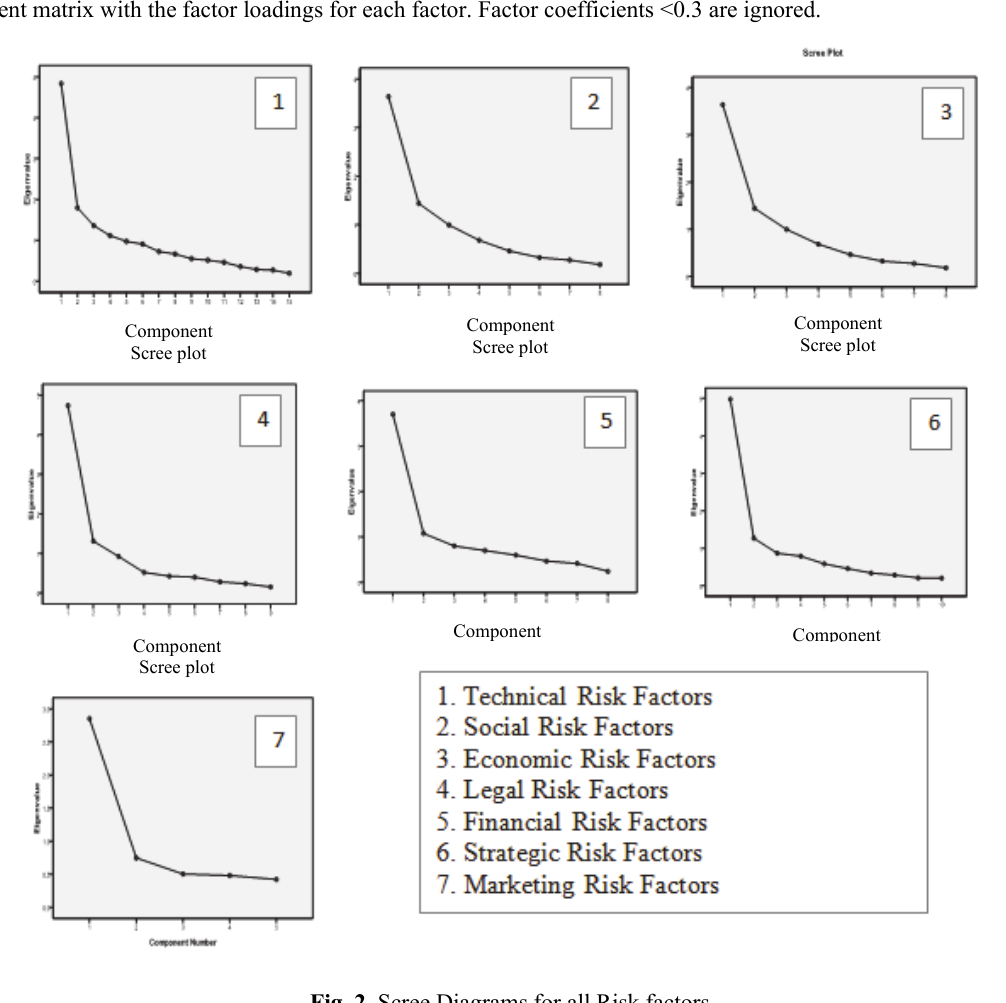
Fig. 2. Scree Diagrams for all Risk